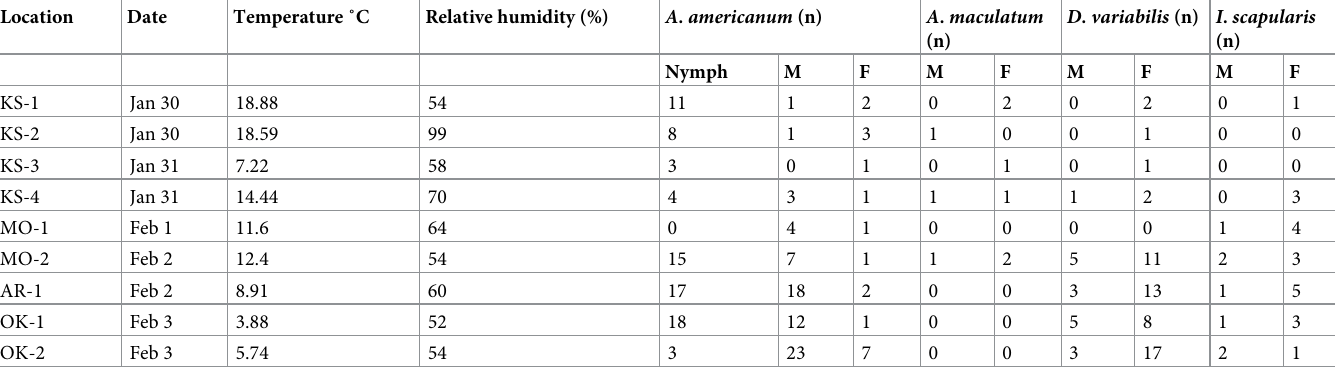
Table 3. Number of ticks caught in different locations during January 30 –February 3, 2017 and the ambient temperature and relative humidity.